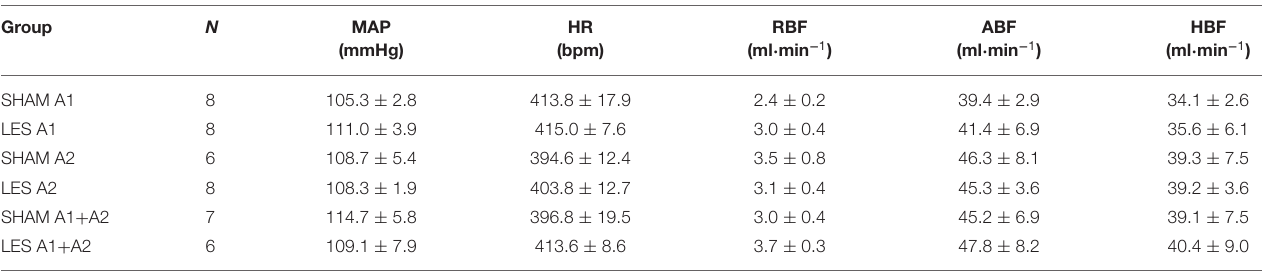
TABLE 1 | Baseline values of MAP, HR, RBF, ABF, and